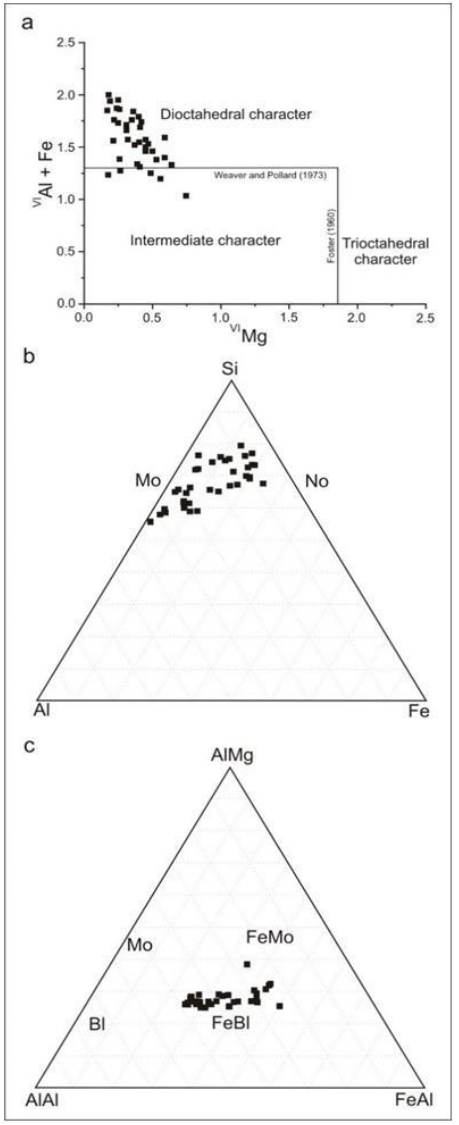
Figure 9. ( a ) Diagram showing dioctahedral, trioctahedral and intermediate character of the smectite formulae; ( b ) triangular Fe-Si-Al composition diagram showing a trend from montmorillonite to nontronite; ( c ) triangular diagram AlAl-FeAl-AlMg [37] showing that smectite corresponds mainly to a Fe-rich beidellite. Bl—beidellite, Mo—montmorillonite, No—nontronite, FeBl—Fe-rich beidellite, FeMo—Fe-rich